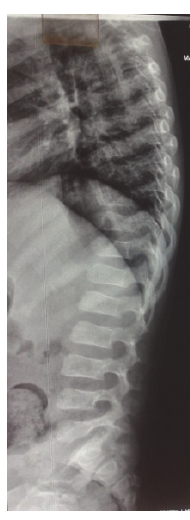
Figure 2: Lateral view of X-ray spine shows wedged shaped vertebral bodies with tongue-like anterior